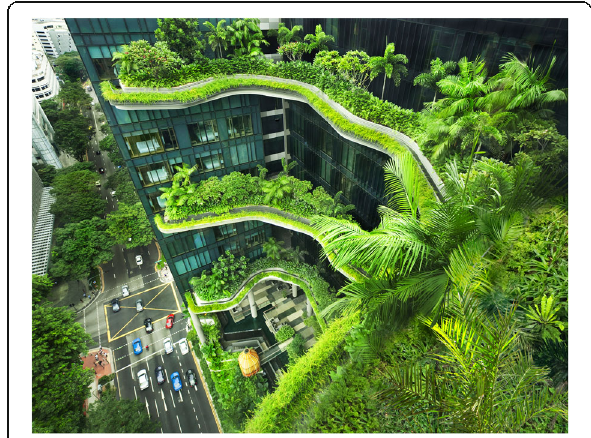
Fig. 6 An example of a green roof and façade from Singapore. Photo taken at the Royal Park Hotel. Note the abundant street trees along Pickering Street. Photo by Timothy